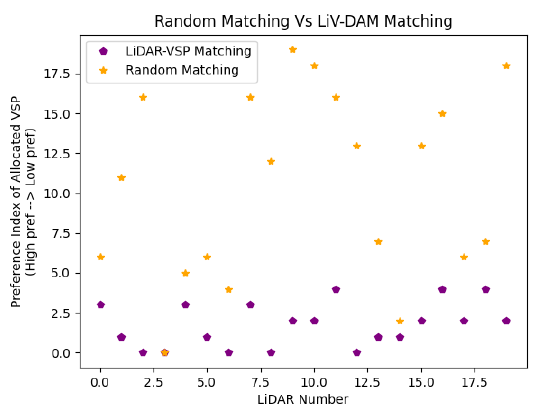
Figure 6. Two-dimensional plot of LiDAR sensors vs. the preference index of the VSP that is allocated Figure 6. 2-dimensional plot of LiDARs vs the preference index of the VSP that is allocated to them. to them.